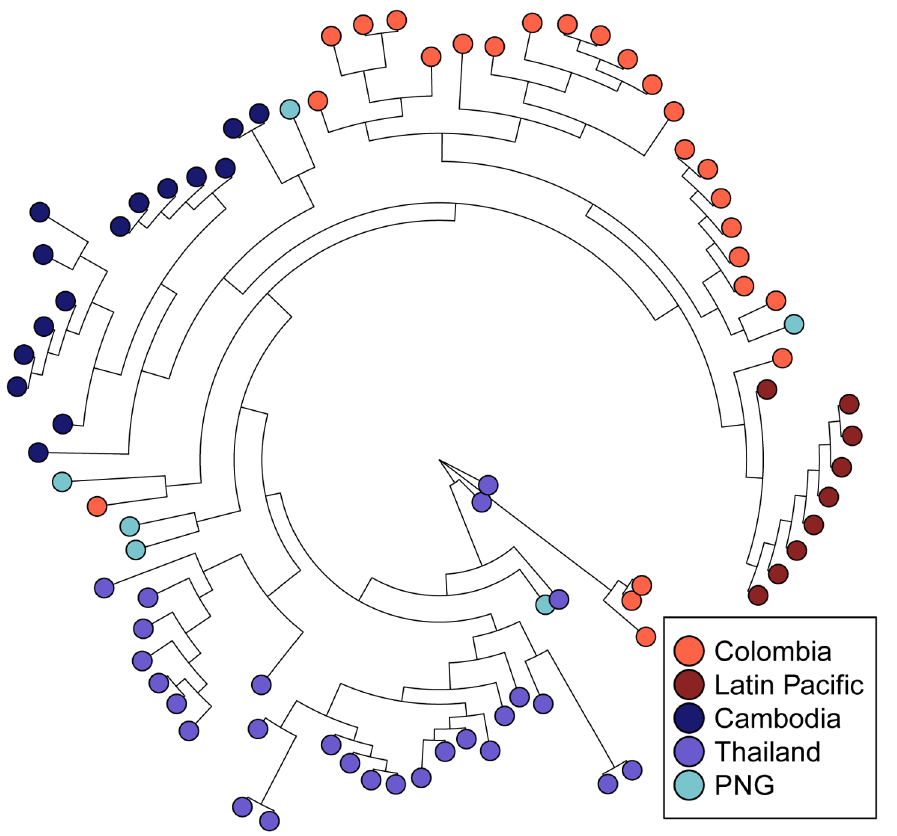
Figure 8. Neighbor-joining tree of pvcsp VK247 repeat arrays. All repeat array haplotypes from each pvcsp VK247 population set were plotted on a single unrooted, neighbor-joining phylogenetic tree. Latin American sequences are in shades of red, South East Asian sequences are in shades of blue.